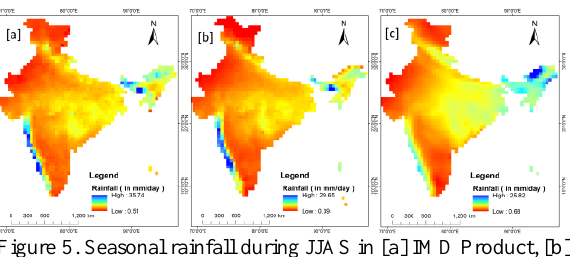
Figure 5. Seasonal rainfall during JJAS in [a] IMD Product, [b] APHRODITE Product and [c] Era-Interim Product